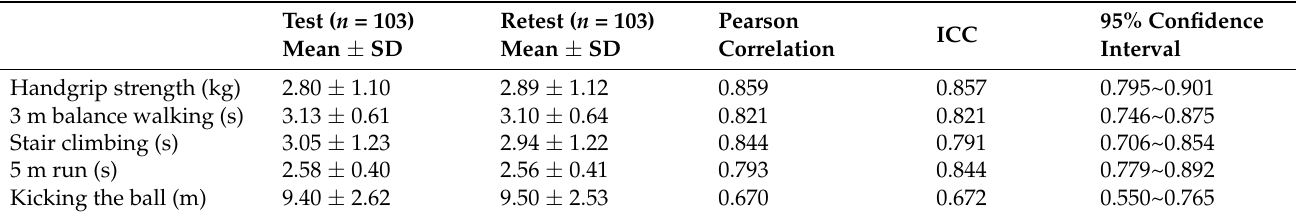
Table 2. ICC of fitness test battery for children aged 2–3 years